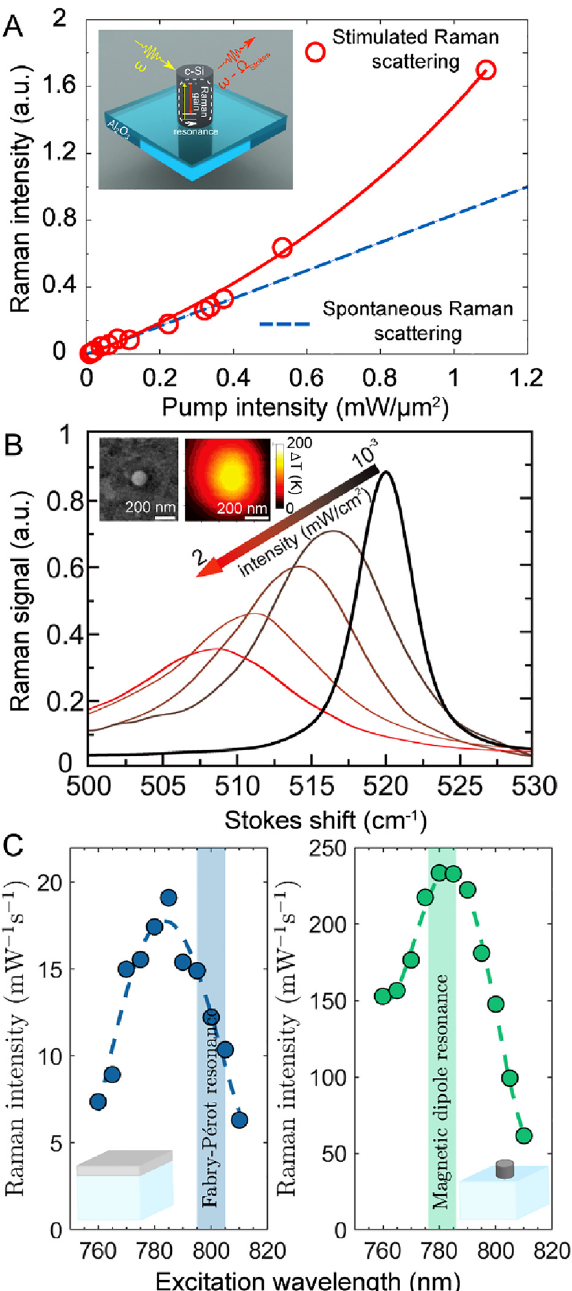
Figure 4: Applications of Raman spectroscopy. (A)StimulatedRamanscatteringfromasiliconnanodiskfordifferent laser pump intensities. The blue line corresponds to the expected trend of spontaneous Raman scattering. Adapted from the study by Zograf et al. [82]. (B) Raman scattering from a silicon nanoparticle for different laser pump intensities. The optical phonon mode broadens and redshifts due to nanoparticle heating. The insets show scanning electron microscope and thermal images. Adapted from the study by Zograf et al. [83]. (C) Tunable-excitation Raman spectroscopy of a silicon thin fi lm and silicon nanodisk array,